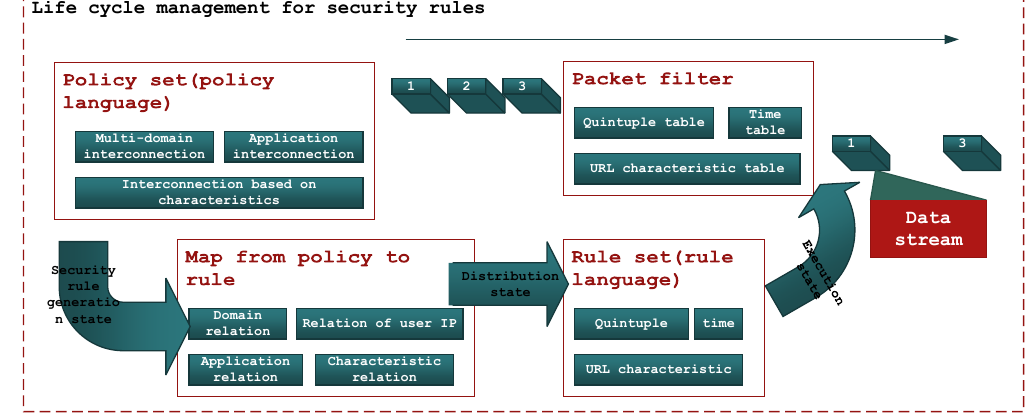
Figure 1. FMNISCF: Fine-grained Multi-domain Network Interconnection Security Control